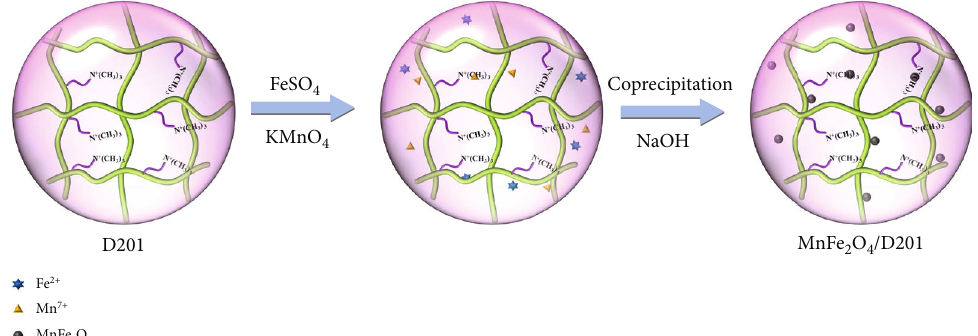
Figure 1: The fl ow chart of MnFe